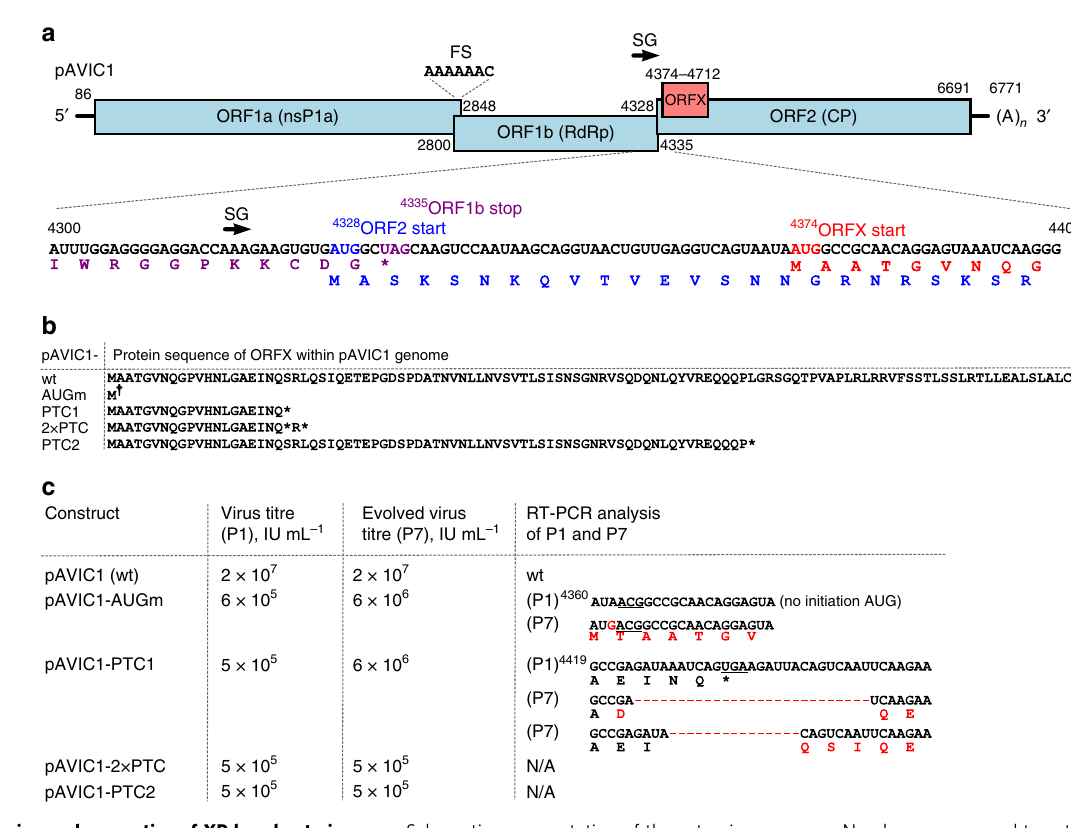
Fig. 3 Design and properties of XP knockout viruses. a Schematic representation of the astrovirus genome. Numbers correspond to astrovirus genome nucleotides in the pAVIC1 infectious clone; FS frameshift signal, SG subgenomic promoter. The sequence of nucleotides 4300 – 4400 is shown below, indicating the positions of overlapping elements and the corresponding translated proteins: ORF1b (purple), ORF2 (blue), and ORFX (red). b XP amino acid sequences for the wt and mutant pAVIC1-derived viruses ( † see main text for note on the AUGm mutant). See Supplementary Fig. 11 for nucleotide and CP amino acid sequences. c Titers (infectious units per mL, IU mL − 1 ) of recombinant viruses after RNA transfection of Huh7.5.1 cells followed by fi rst passage (P1) and after seven passages (P7) in Caco2 cells. RT-PCR analysis of viral RNA isolated after P1 and P7 for selected recombinant viruses. See Supplementary Fig. 12 for sequencing chromatograms of individual